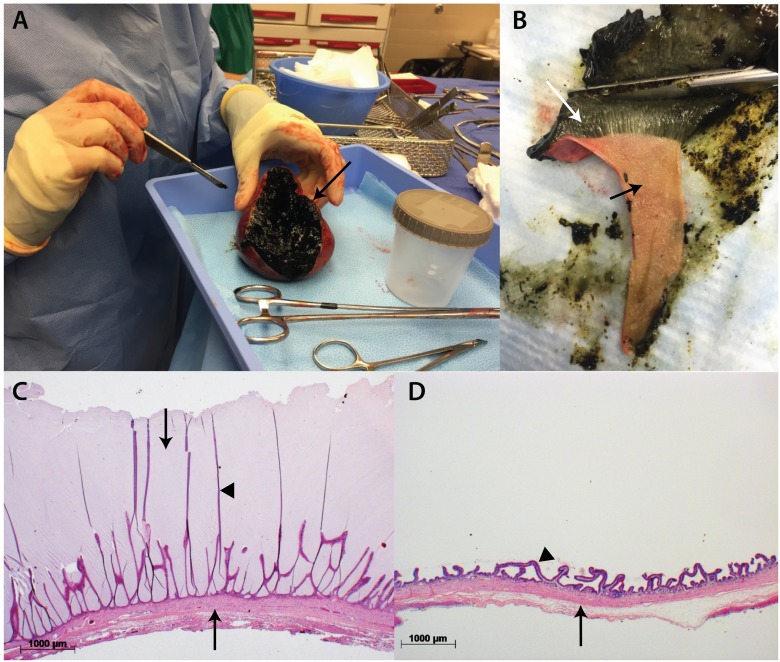
Gross and microscopic appearance of the internal contents of a gallbladder mucocele.Gross appearance of the internal contents of a mucocele immediately after surgical removal of the gallbladder from an affected dog (Panel A). In Panel A, the gallbladder has been incised from the neck to the apex along the margin indicated by the arrow resulting in exposure of the bile-stained, blackened mucus content. Panel B demonstrates firm adhesion of the gallbladder mucus (white arrow) as it is being “peeled” away from the lumen surface of the gallbladder mucosa (black arrow) using a scalpel. Panel C and D demonstrate a cross section of gallbladder mucosa (upward arrows) from a dog with mucocele formation and a control dog, respectively. In Panel C the gallbladder lumen (downward arrow) is effaced by solidified mucus into which extends thin papillary projections of the mucosal folds (closed arrowhead). In Panel D the lumen is devoid of mucus and normal mucosal folds can be visualized (closed arrowhead). Hematoxylin and eosin stain.